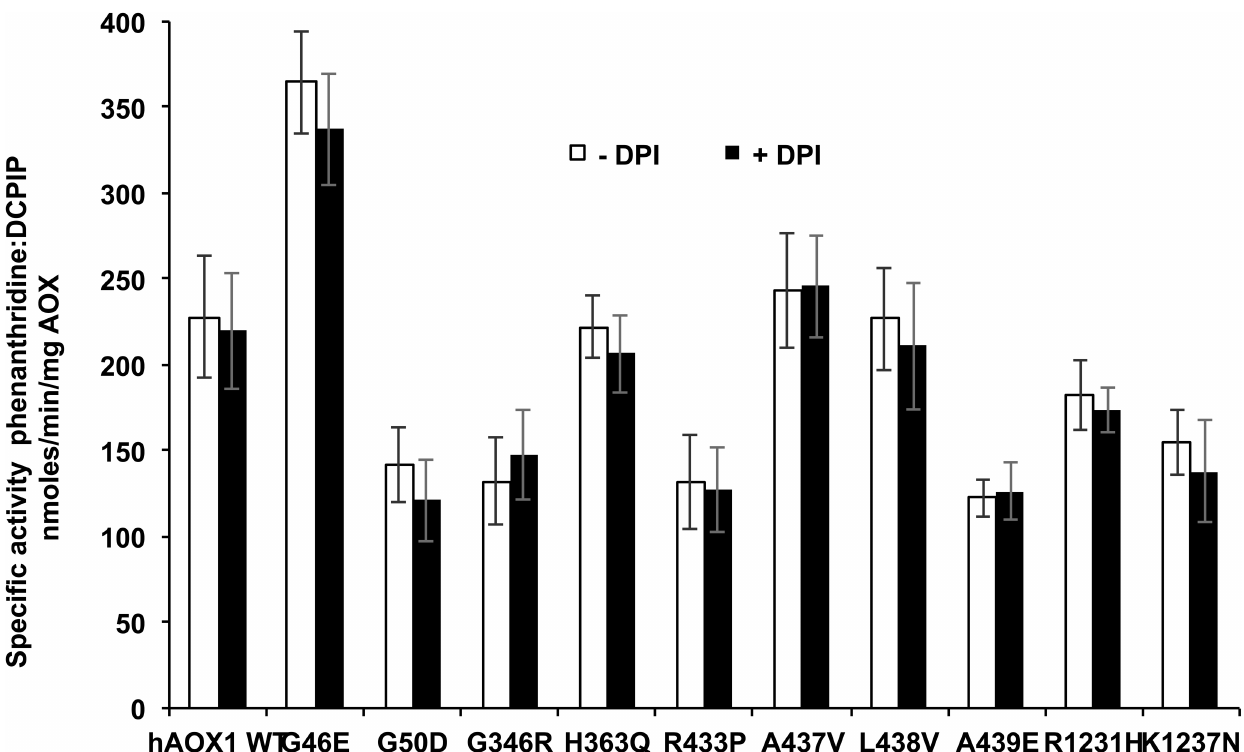
Fig 4. The effect of diphenyleiodonium on the activity of hAOX1 variants. Specific activities of hAOX1 wild-typeand SNP-based variants with 80 μ M phenanthridineas substrate and 100 μ M 2,6-dichlorophenolindophenol (DCPIP) as electronacceptor in absenceor presenceof 5 μ M diphenyleneiodonium